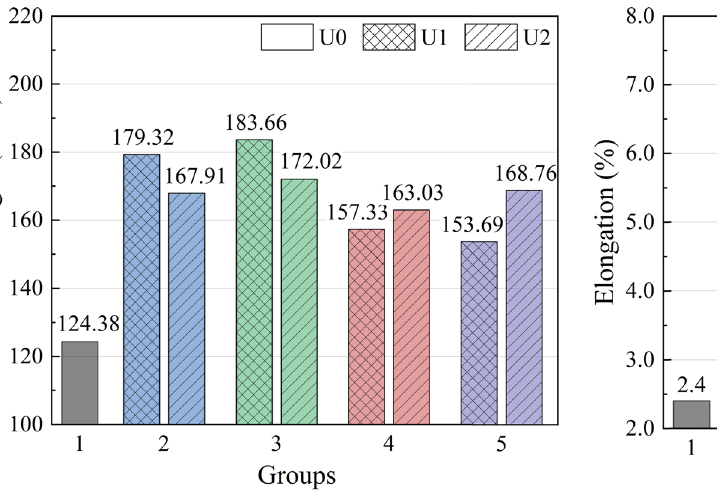
Figure 6: Comparison of the tensile strengths of the casting samples in di ff erent states.